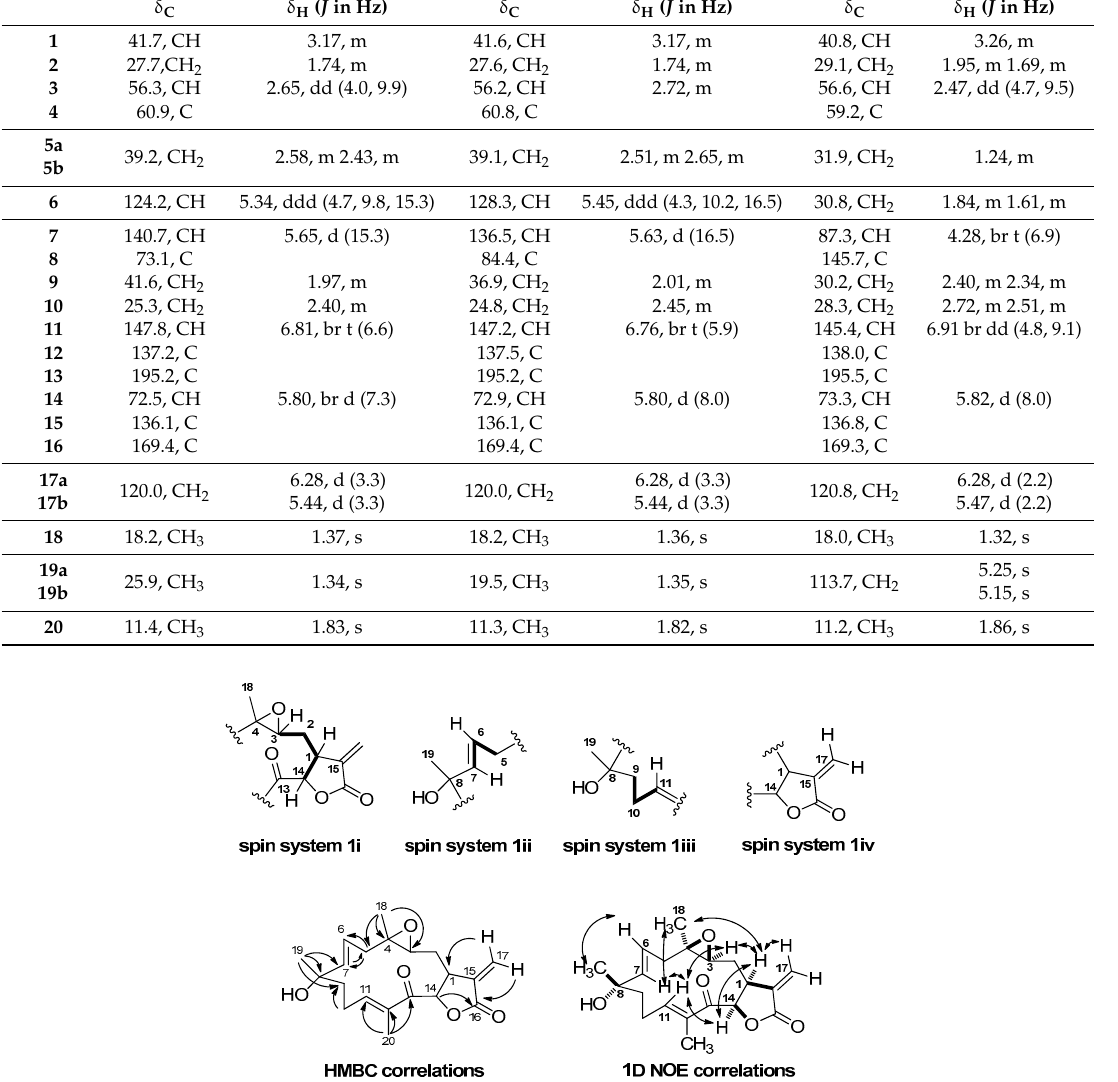
Table 1. 1 H- and 13 C-NMR data in ppm for uprolides N, O and P ( 1 – 3 ) measured in CDCl 3 at 400 MHz.